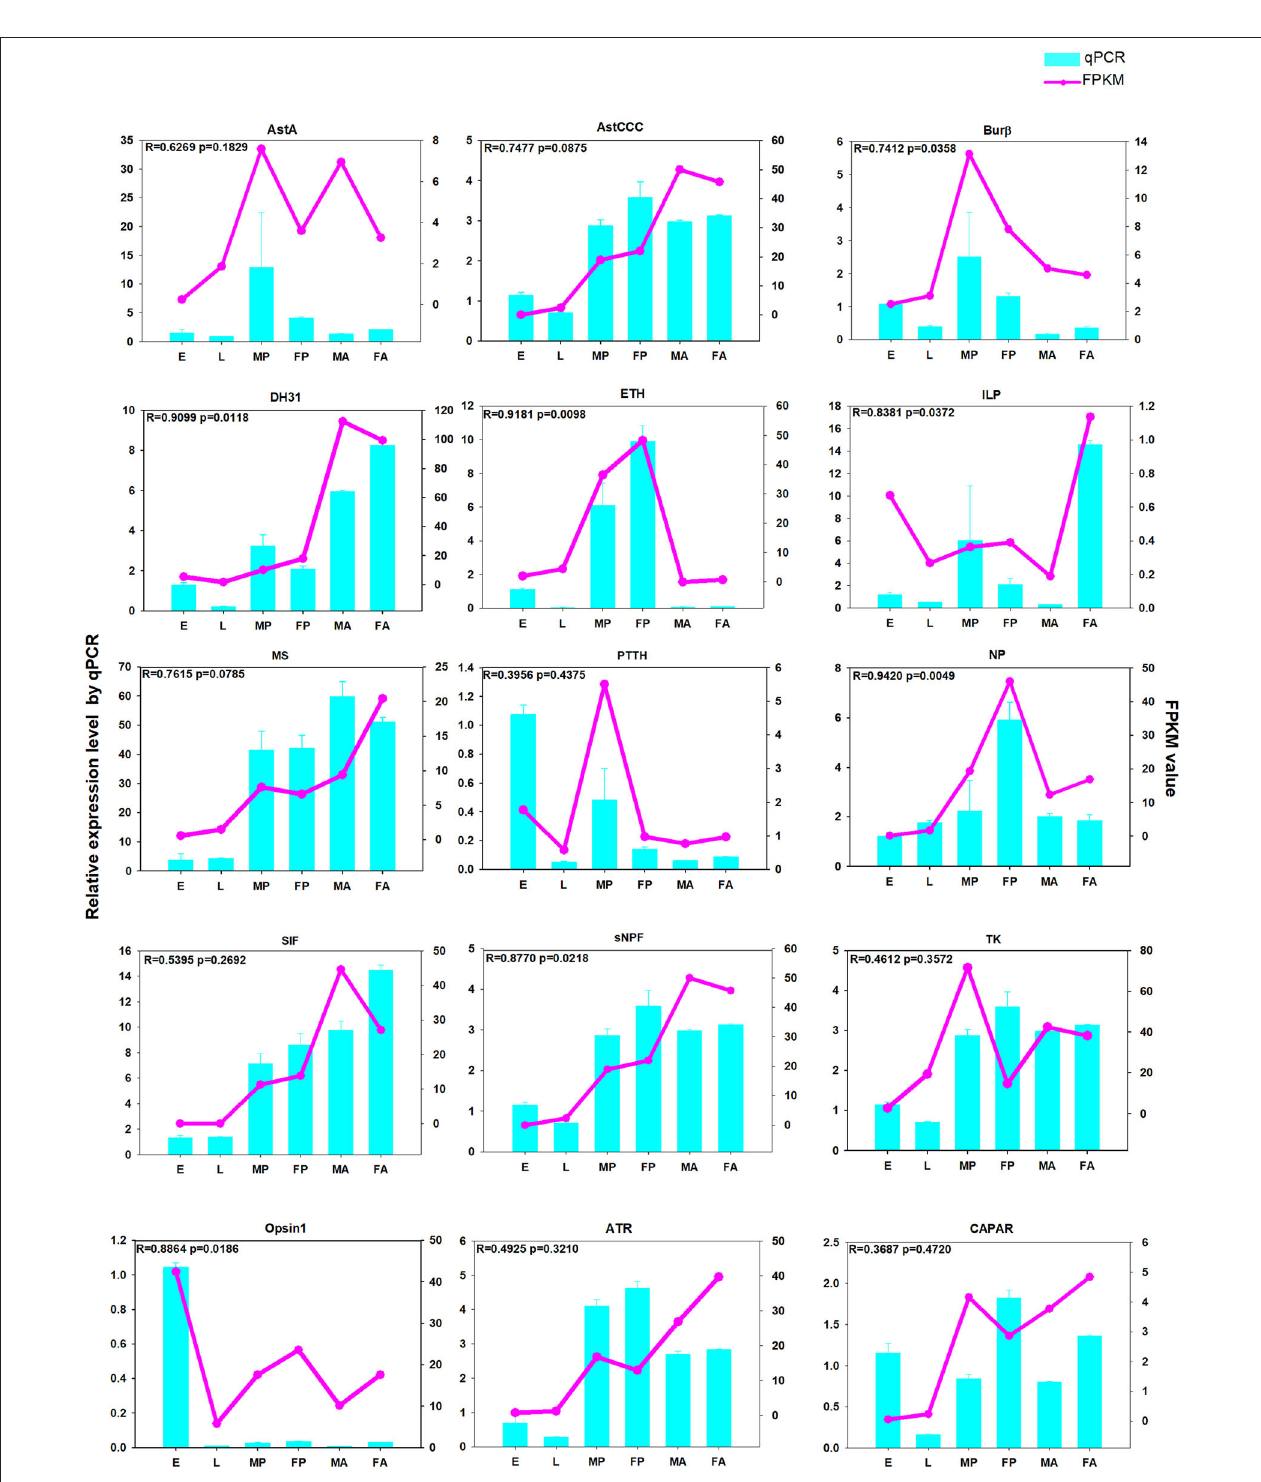
FIGURE 11 | The qPCR analysis of relative expression levels of neuropeptide genes and neuropeptide receptor genes at different developmental stages. E, embryos; L, larvae; FA, female adults; FP, female pupae; MA, male adults; MP, male pupae. The pink-dotted line represents the FPKM (fragments per kilobase of transcript per million) value, and the relative expression levels from the qPCR are depicted in the light blue histogram.